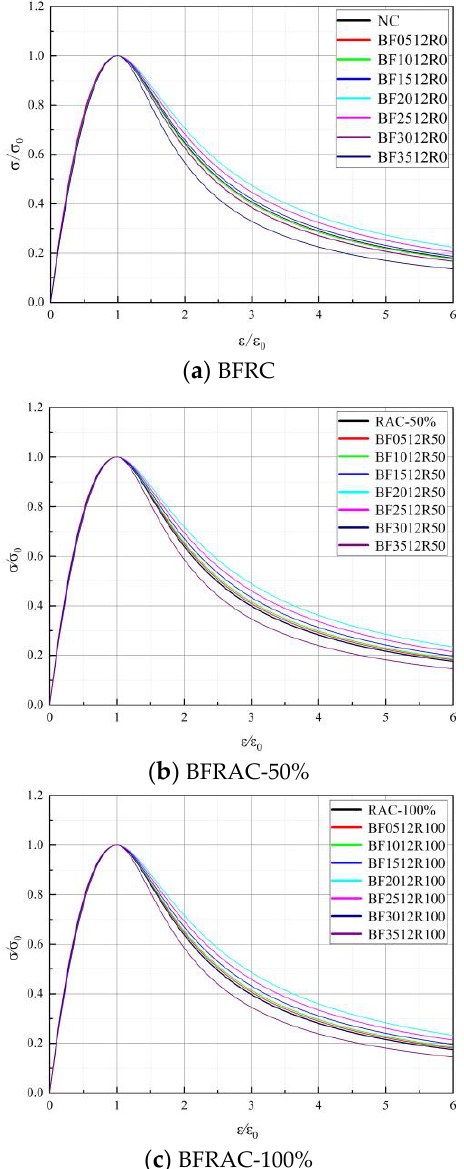
Figure 18. Axial compressive stress – strain curve fitting of BFRAC.